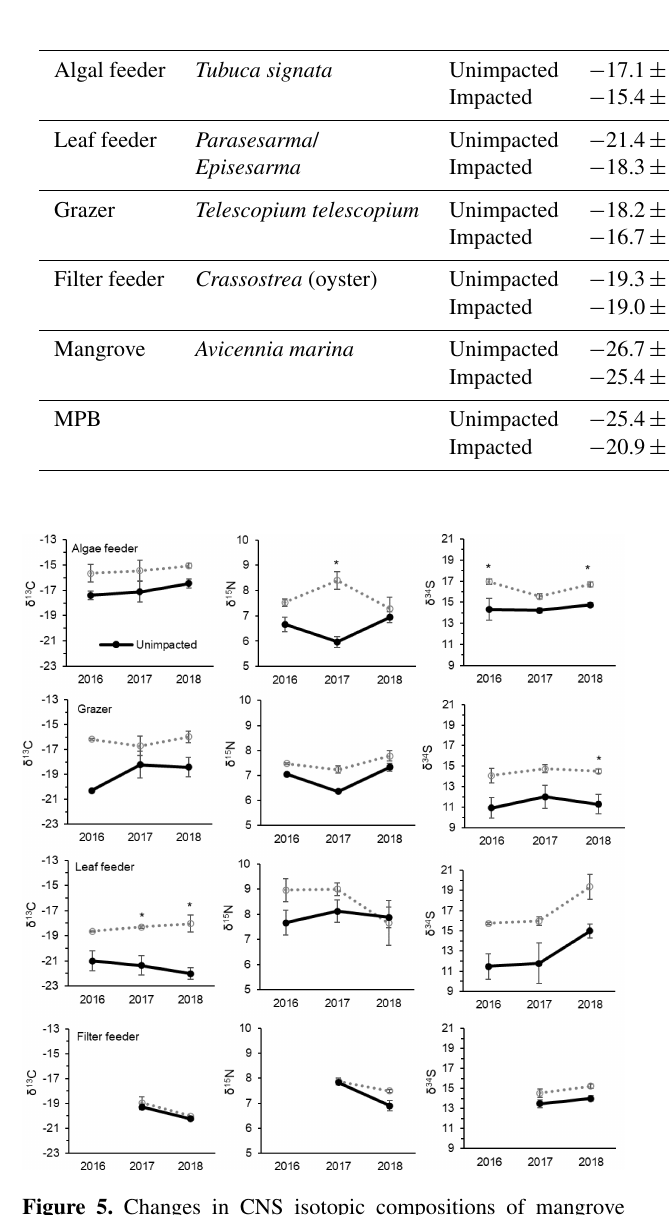
Figure 5. Changes in CNS isotopic compositions of mangrove macrofaunal groups with four different feeding modes from 2016, 2017 and 2018 (i.e. 8, 20 and 32 months after the event) between the unimpacted reference and impacted mangrove forest sites. Error bars are ± SE ( n = 2 to 6 per data point). An asterisk ( ∗ ) indicates a significant difference in the year. Mean ± SE values and sample sizes are also provided in Table